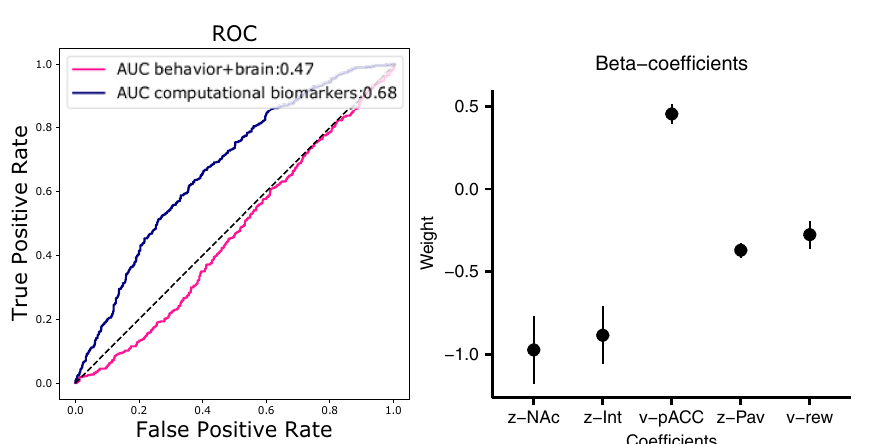
Fig 4. Classification of MDD status and feature importance for the computational biomarker classifier. Left , the receiver operating characteristic (ROC) curve and the ROC area under curve (AUC) statistic for a classifier using individual parameter values from the computational model (purple) and a classifier using mean observed behavioral measures of response time and approach rate and mean activity in ROIs (caudate nucleus, nucleus accumbens (NAcc), pregenual anterior cingulate cortex (pACC), and subthalamic nucleus (STN)). Right , mean estimated beta-coefficients from classifier with 95% confidence intervals for the classifier using computational biomarkers (purple). Coefficients are sorted by weight from left to right as the absolute distance from 0, the magnitude of which indicates the importance of each feature for the classification. Int = Intercept, PavBias = Pavlovian bias, v = drift rate, z = starting-point